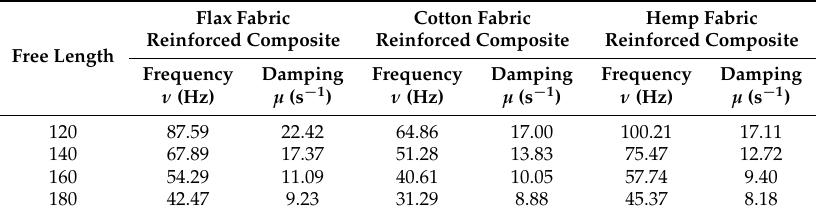
Table 7. The vibration behavior of the composite material